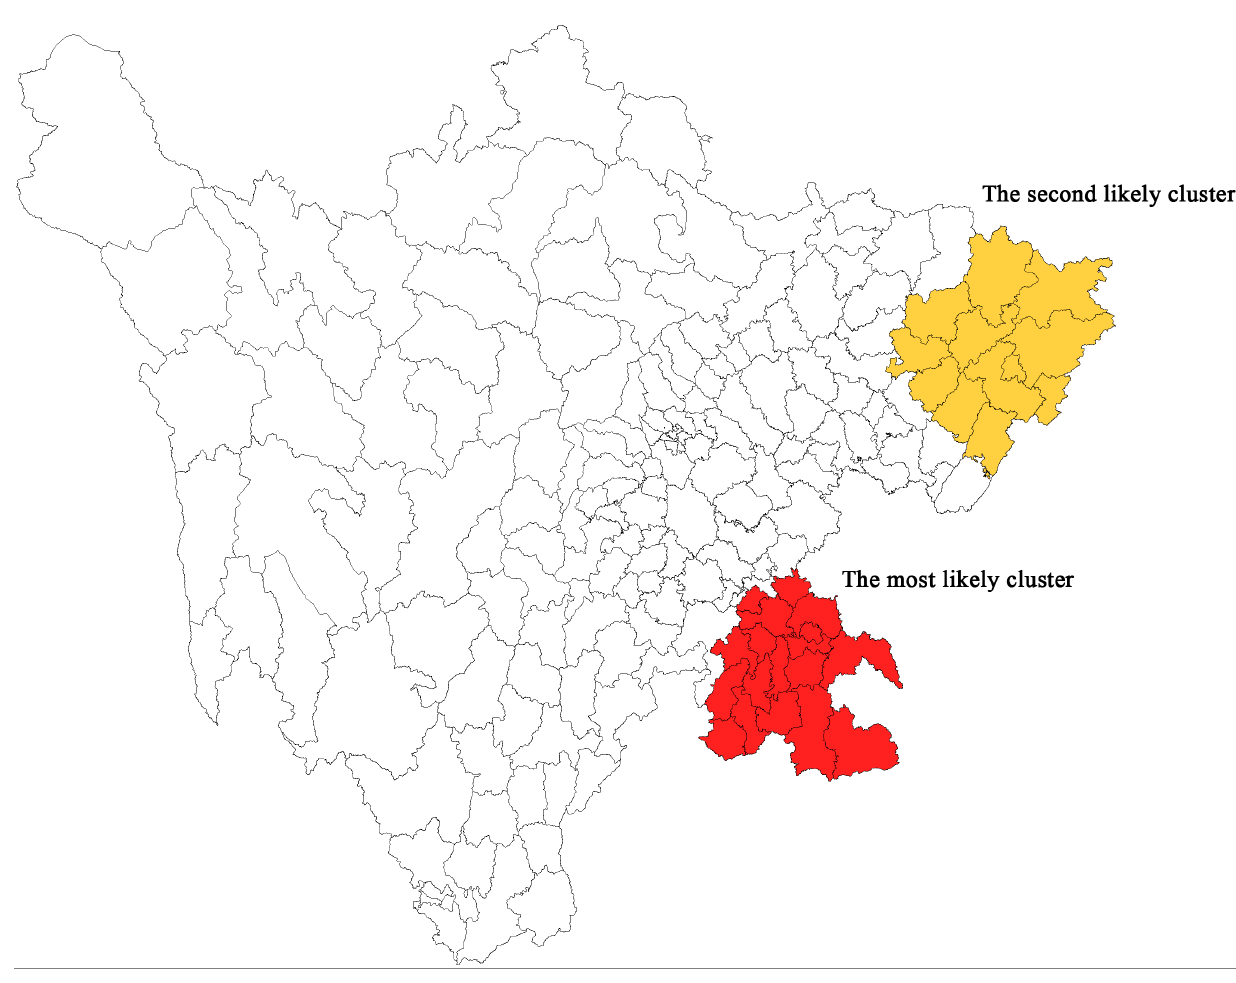
Figure 2. Detected clusters of Japanese encephalitis in Sichuan province in 2009. On a significance level of 0.05, the test statistics based on Poisson and Hypergeometric models obtained almost the same results. They detected two significant clusters, the most likely cluster in the southeast with 18 counties and one secondary cluster in the northeast with 12 counties, both with P value of 0.0001. They differs slightly on statistically insignificant clusters.